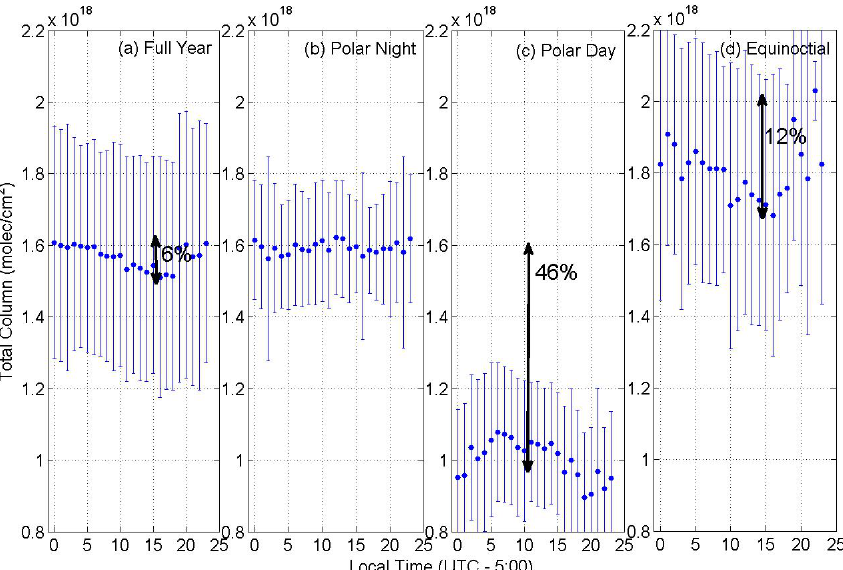
Fig. 6. 24h diurnal cycle of CO during each season as measured by the E-AERI during 2008–2009: (a) averaged across the full year, (b) averaged during polar night (no sun), (c) averaged during polar day (only sun), and (d) March and September averaged during ∼ 12h of sunlight (equinoctial). Error bars represent the standard deviation of the hourly